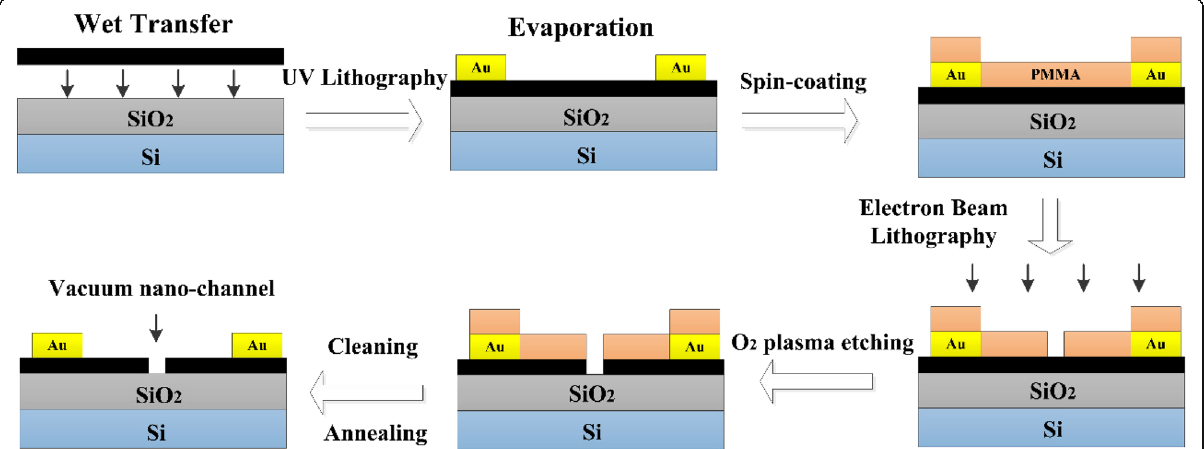
Fig. 3 Schematic diagram of the fabrication process of the graphene-based nanoscale vacuum channel transistor